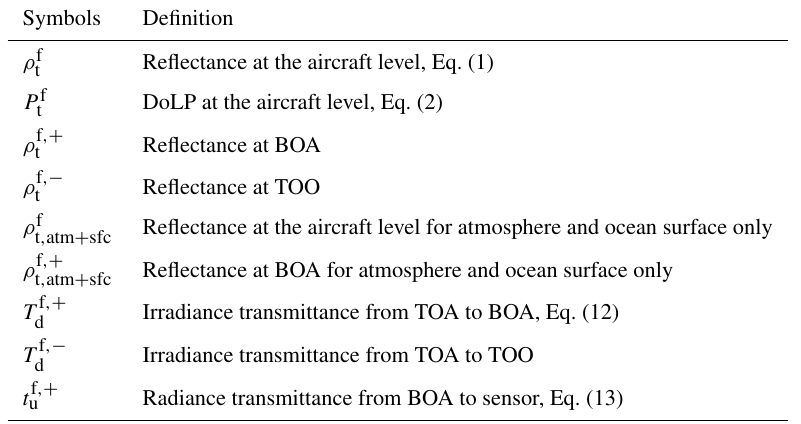
Table 1. Definition of the symbols for the quantities computed from the forward model (indicated by the superscript f) as shown in Fig. 1.